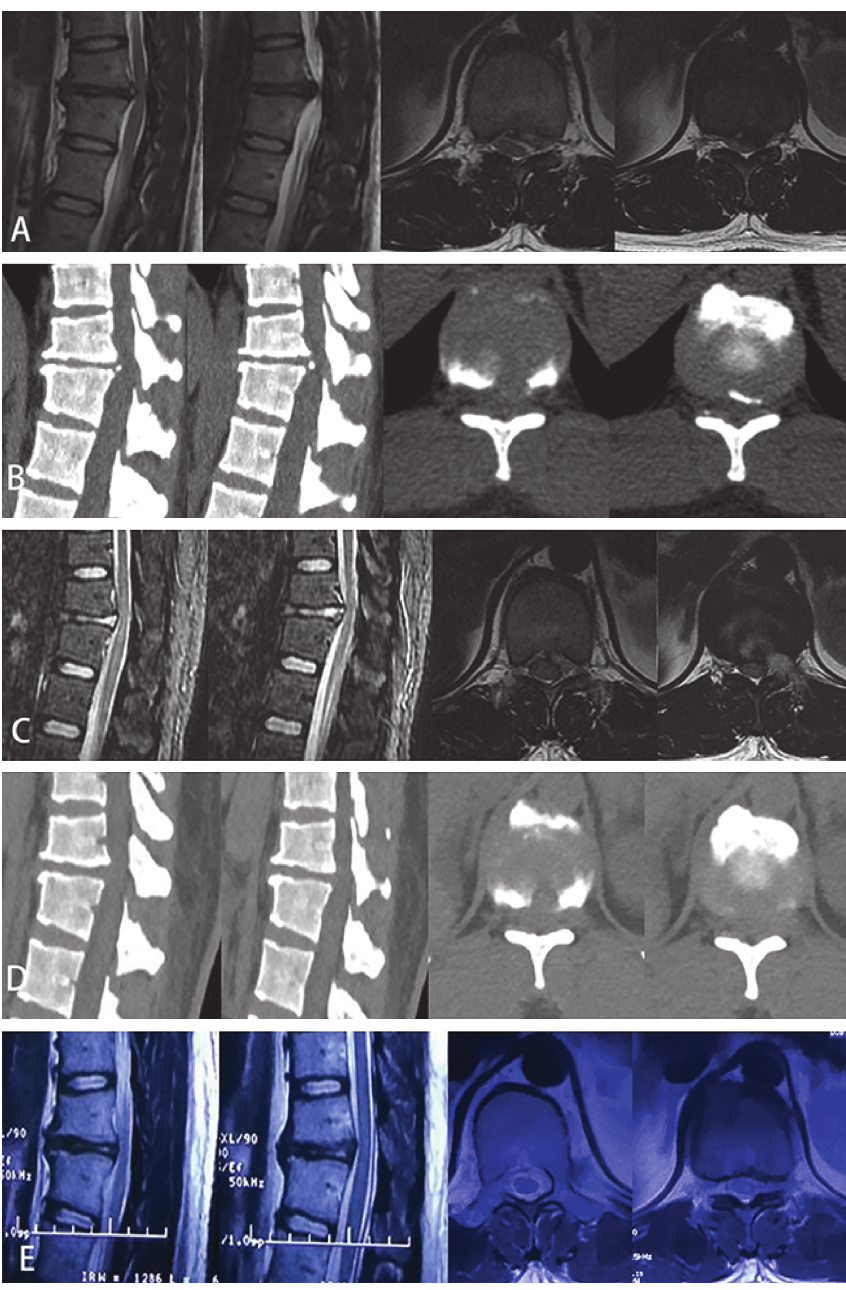
Figure 6: Preoperative MRI (a) and CT (b) scan showing spinal cord compression by calcified disc herniation and posterior vertebral osteophyte at T11-T12 (case 3). Postoperative MRI (c) and CTscan (d) showing sufficient decompression of the spinal cord and the calcified disc was cut off clearly. MRI at the 3-month follow-up (e) showing the spinal cord surrounded by cerebrospinal